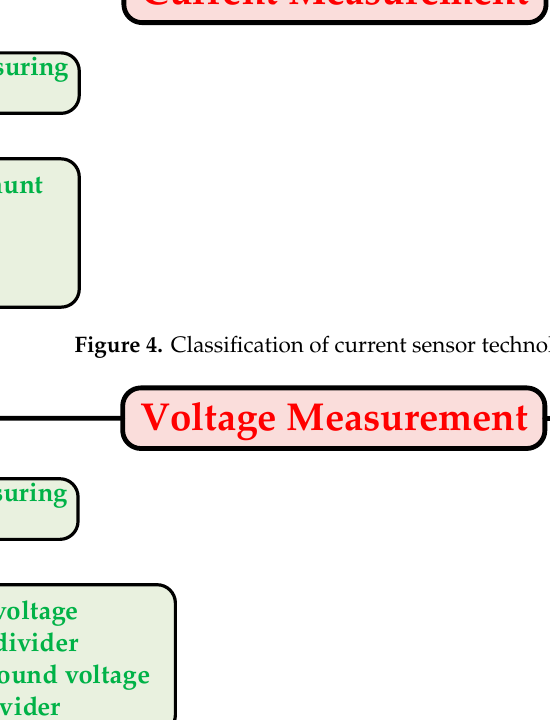
Figure 4. Classification of current sensor technologies.